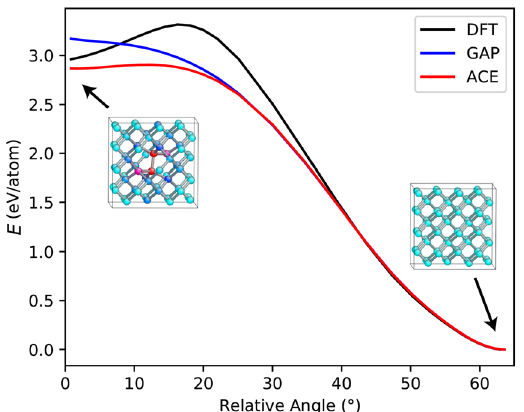
Fig. 9 Fourfold-coordinated defect. Minimum energy path con- necting the fourfold defect to bulk crystal silicon evaluated using the ACE model in a 64 atom cell. We also show the energies of GAP and DFT on the exact same